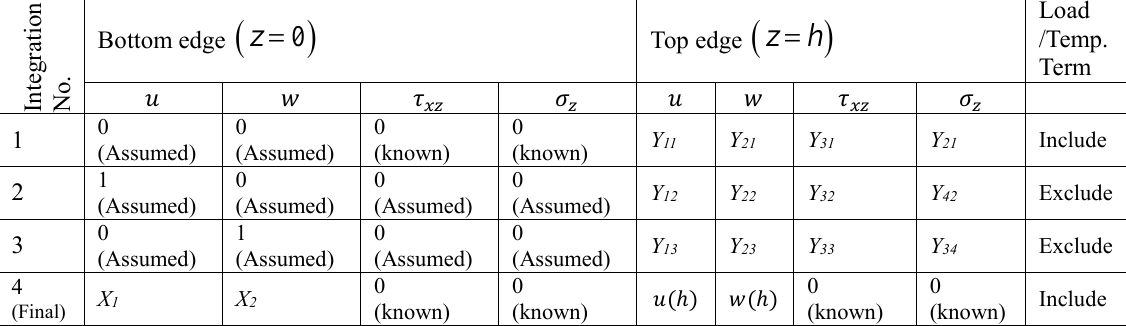
Transformation of BVP into IVP's for stress